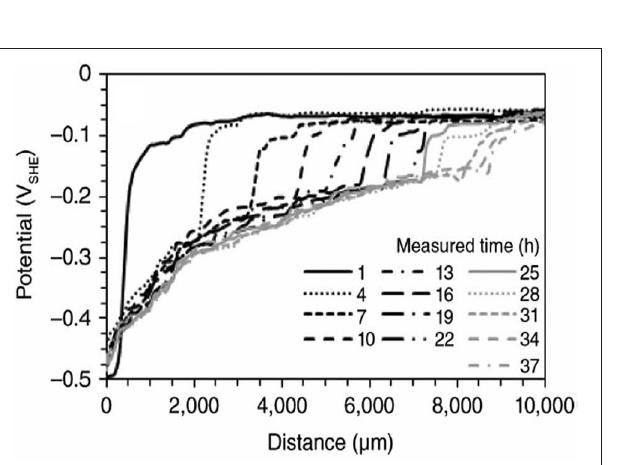
for steel—epoxy system as function of distance for different times of exposure in neutral 0.5 M Na 2 SO 4